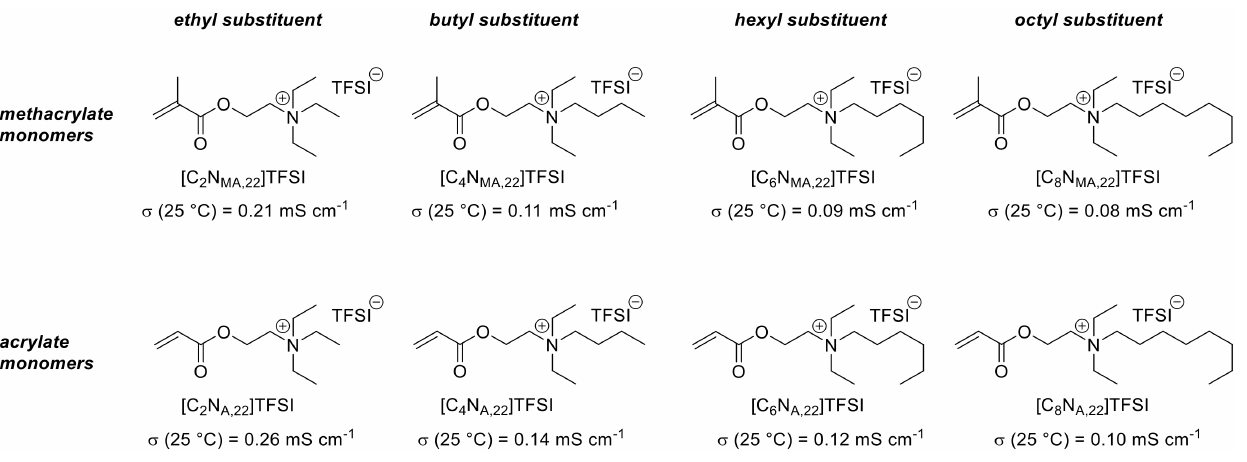
Figure 1. Previously introduced ionic liquid monomers and their ionic conductivities at 25 ◦ C